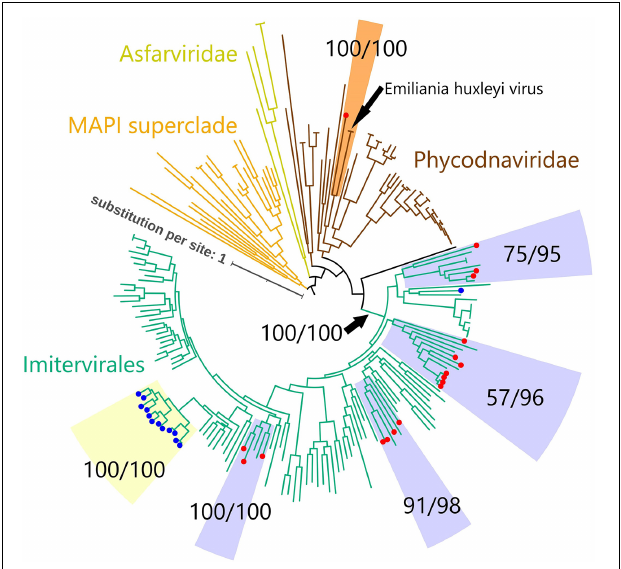
FIGURE 3 | Phylogeny of myosin from NCLDVs and eukaryotic lineages. The tree was built from the multiple sequence alignment (658 sites) of 286 myosin head domain sequences. Branches are color-coded based on taxonomic groups (orange branches correspond to virmyosins). The Imitervirales virmyosin clade (highlighted with a pale blue-colored background) was supported with a bootstrap value of 71% of and TBE of 98%. We consider myosin-II as an outgroup to root this tree. The LG + R10 substitution model was selected by IQ-TREE for the best model for tree